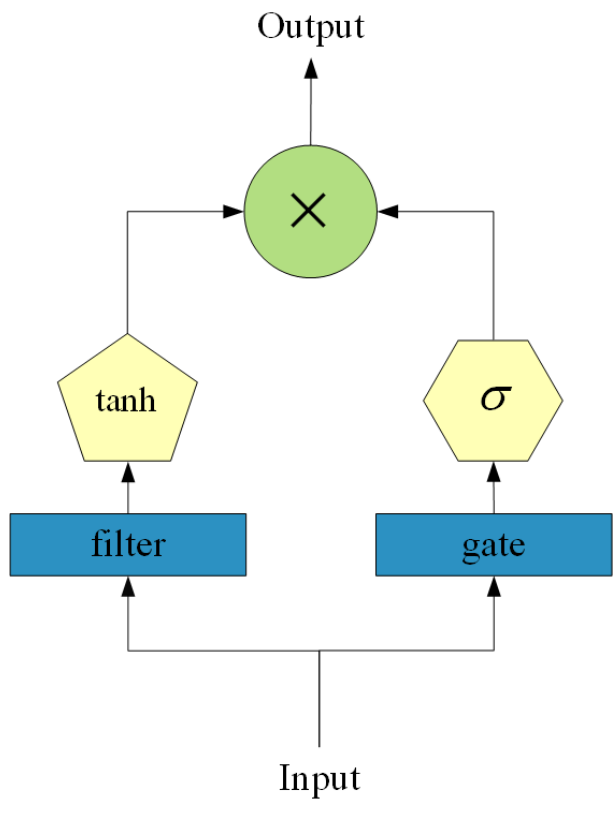
Figure 3. The framework of Gate